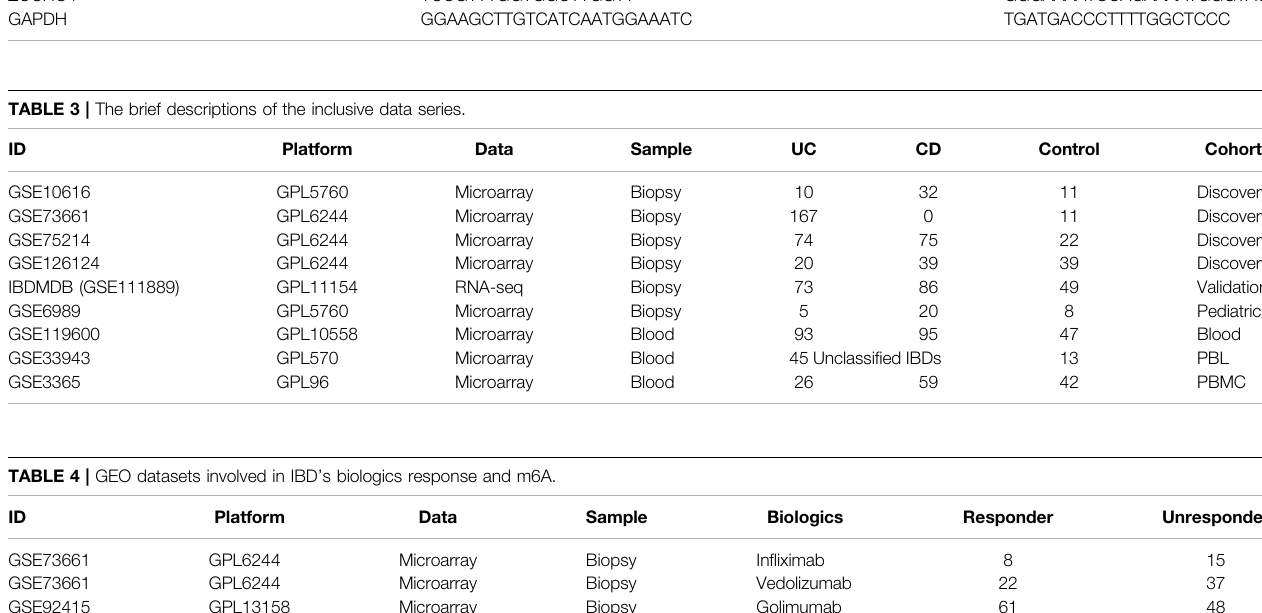
GSE3365 for comparison between IBD peripheral blood